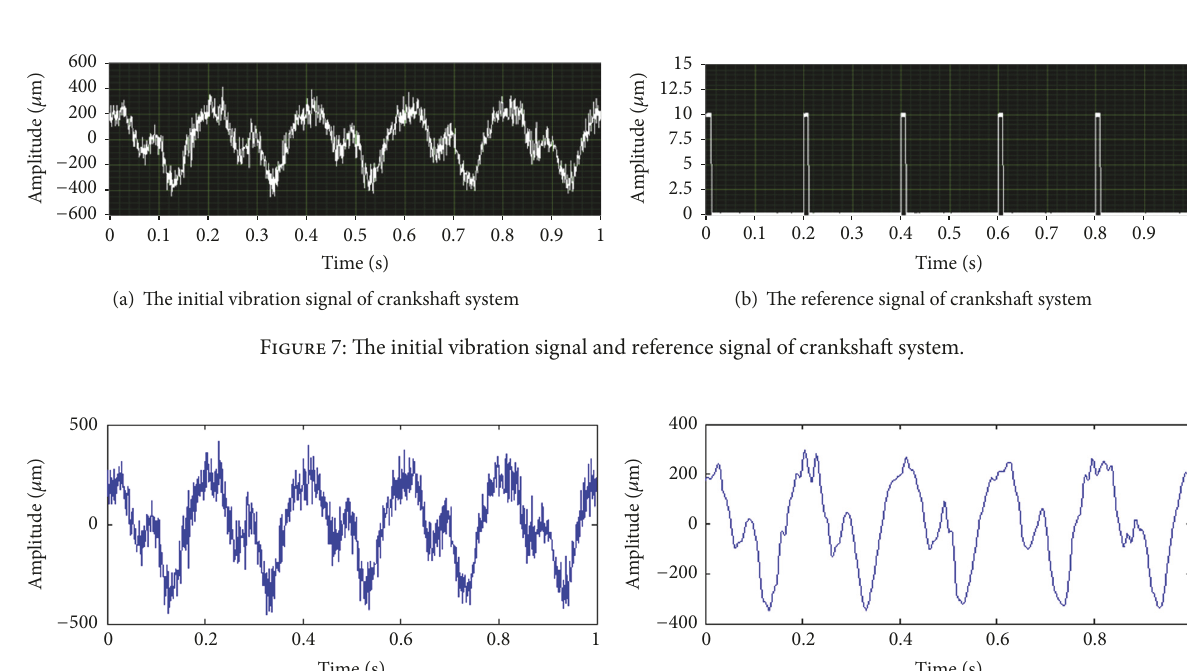
Figure 6: Field measuring system.